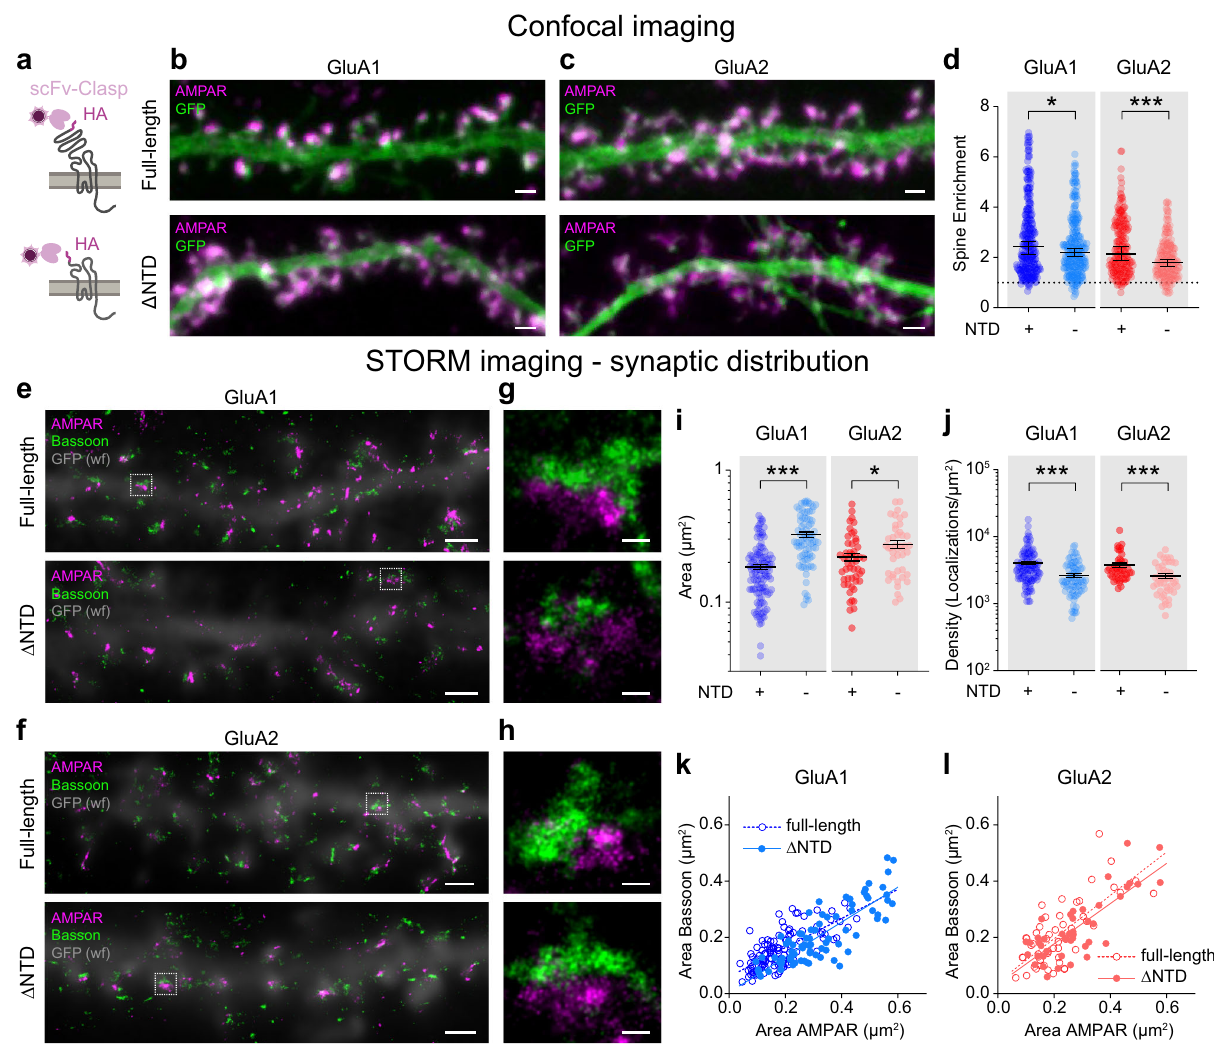
Fig. 5 Synaptic distribution of NTD-deleted receptors. a Exogenous surface HA-tagged receptors in cultured hippocampal neurons were live-labelled with fl uorescently conjugated single-chain Fv-Clasp (ScFv-Clasp) avoiding arti fi cial protein cross-linking. b – c Representative confocal images of full-length (top) and Δ NTD (bottom) GluA1 b and GluA2 ( c ) (AMPAR – magenta, GFP – green, Scale bars: 1 µ m). For n -numbers see legend to panel d. d Δ NTD receptors were slightly de-enriched at dendritic spines (spine/dendrite fl uorescence, left, GluA1 full-length: 2.42 ± 2.11 – 2.63, n = 294 spines/16 cells; GluA1 Δ NTD: 2.18 ± 2.03 – 2.37, n = 267 spines/16 cells, fi ve preparations; p = 0.0473, two-tailed Mann – Whitney test; right, GluA2 full-length: 2.14 ± 1.90 – 2.44, n = 200 spines/14 cells; GluA2 Δ NTD: 1.79 ± 1.65-1.93, n = 187 spines/12 cells, four preparations; p < 0.0001, two-tailed Mann – Whitney test). e – h Representative 3D STORM images of full-length (top) and Δ NTD (bottom) GluA1 e and GluA2 f receptors (magenta) co-labelled with presynaptic marker bassoon (green). Wide fi eld (wf) GFP images overlayed in grey (Scale bars: 1 µ m). g – h Magni fi ed synaptic clusters within boxed areas in e – f (Scale bars: 100 nm). i Δ NTD GluA1 (areas ( µ m 2 ), left, GluA1 full-length: 0.183 ± 0.009, GluA1 Δ NTD: 0.325 ± 0.015; p < 0.0001, two-tailed unpaired t test) and Δ NTD GluA2 receptors (areas ( µ m 2 ), right, GluA2 full-length: 0.220± 0.015, GluA2 Δ NTD: 0.274 ± 0.019; p < 0.0193, two-tailed unpaired t test) occupied larger synaptic areas than respective full-length controls upon 3D STORM imaging. j NTD deletion in both GluA1 (densities (Localisations/ µ m 2 ), left, GluA1 full- length: 4087 ± 248.8, GluA1 Δ NTD: 2648 ± 164.6; p < 0.0001, two-tailed unpaired t test) and GluA2 (densities (Localisations/ µ m 2 ), right, GluA2 full- length: 3787 ± 276.4, GluA2 Δ NTD: 2590 ± 208.5; p < 0.0001, two-tailed unpaired t test) reduced receptor densities at the synapse. k – l Postsynaptic AMPAR areas correlated with presynaptic bassoon areas ( k , slope± S.E. GluA1 full-length: 0.5175 ± 0.049 (R 2 0.5024), GluA1 Δ NTD: 0.6235 ± 0.049 ( R 2 = 0.6768), p = 0.1268, F test: F (DFn, DFd) = 2.353 (1, 189)) and GluA2 Δ NTD ( l , slope ± S.E. GluA2 full-length: 0.7698 ± 0.1056 ( R 2 0.5202), GluA2 Δ NTD: 0.7155 ± 0.082 ( R 2 = 0.6435), p = 0.6857, F test: F (DFn, DFd) = 0.1648 (1, 91)). Data shown as median± lower-upper 95% CI (panel d) or mean ± S.E.M (panels i – j ), * indicates p < 0.05, and *** p < 0.001. STORM data (panels e – l ) were obtained from three culture preparations for GluA1 (GluA1 full-length: 113 synapses/12 cells, GluA1 Δ NTD: 80 synapses/16 cells) and from four preparations for GluA2 (GluA2 full-length: 51 synapses/nine cells, GluA2 Δ NTD: 44 synapses/10 cells). Source data are provided as a source data fi